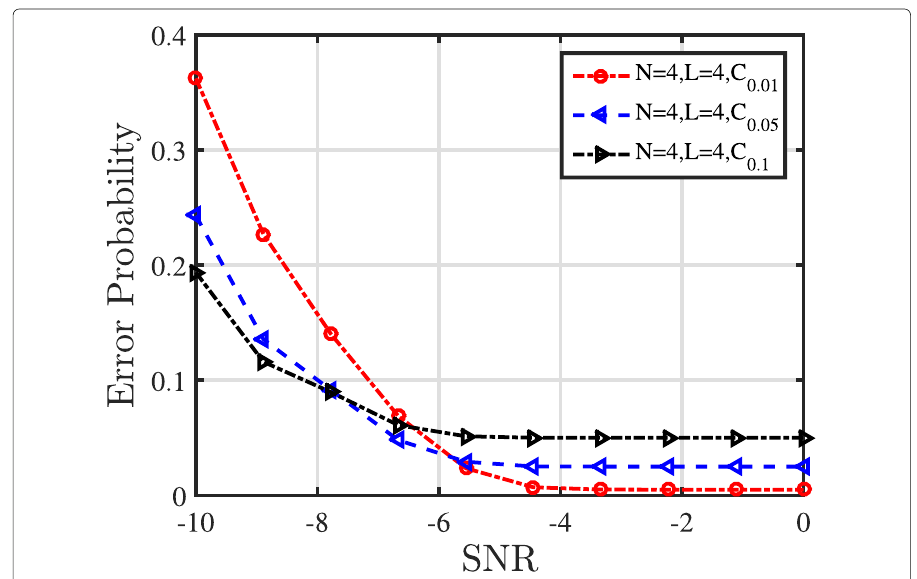
Fig. 4 Effect of error floor value on the classifier performance for C 0.01 , C 0.05 and C 0.1 for D 1 ={BPSK,QPSK}. Higher error floor values gain us in low-SNR value performance improvements